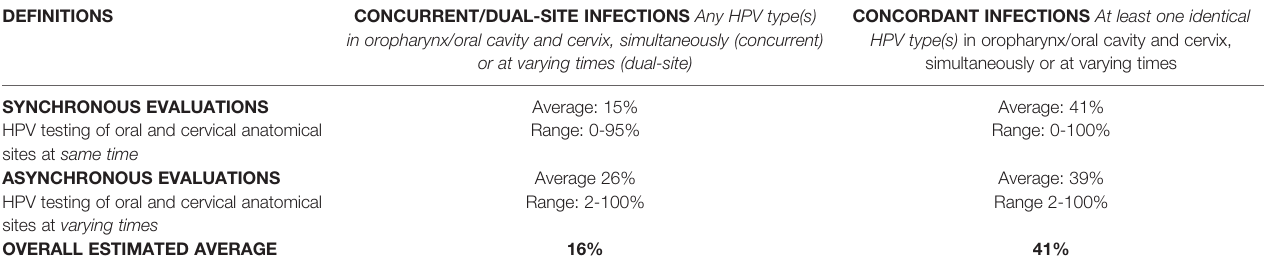
TABLE 1 | De fi nitions and summary statistics for a 1990-2021 systematic review of oral-cervical human papillomavirus (HPV) infection/cancer rates in women.